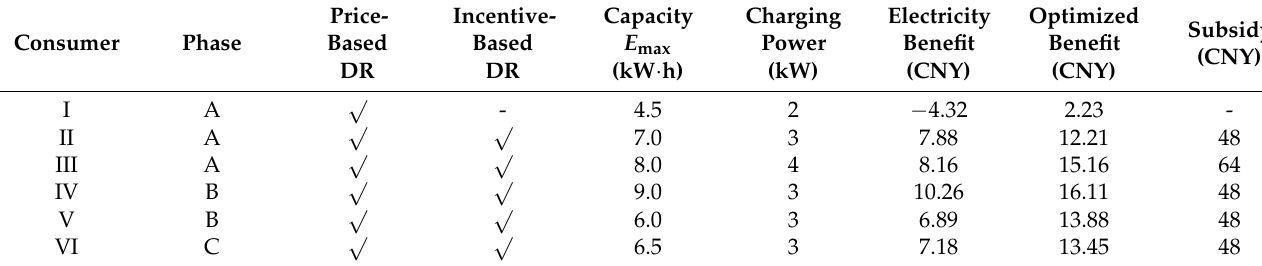
Table 3. Scenario data.